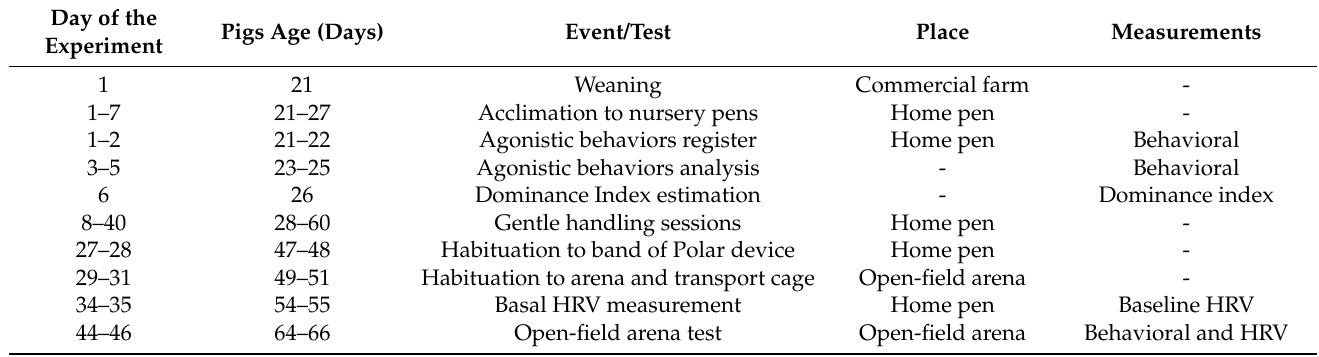
Table 1. Schedule of the